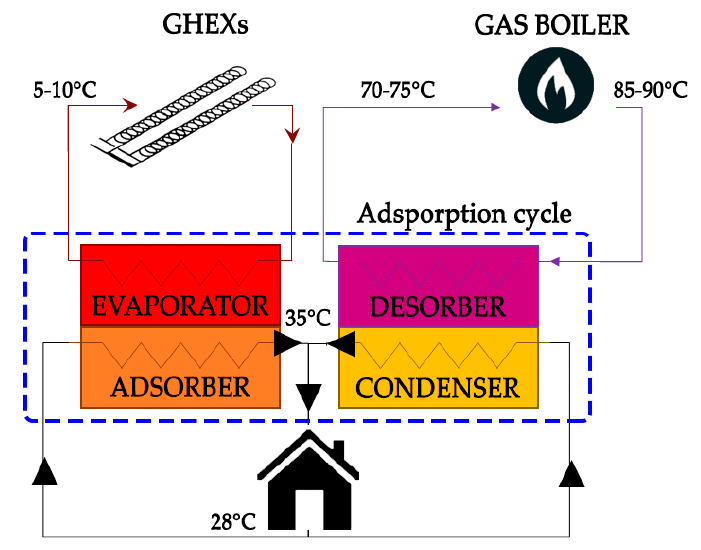
Figure 6. Designed location of the slinky ground source heat exchangers (GHEXs) with respect to the building.